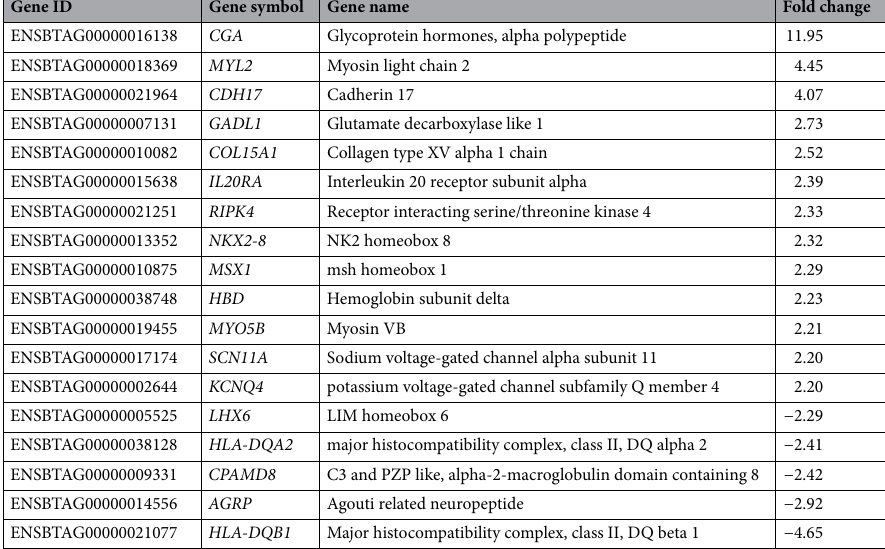
Table 1. Gene ID, gene symbol, gene name, and fold change of most upregulated and downregulated (fold change > 2) differentially expressed genes (DEGs) in the arcuate nucleus of prepubertal heifers on high vs moderate planes of nutrition (q < 0.05). For full list of DEGs, see Supplemental Table S2.